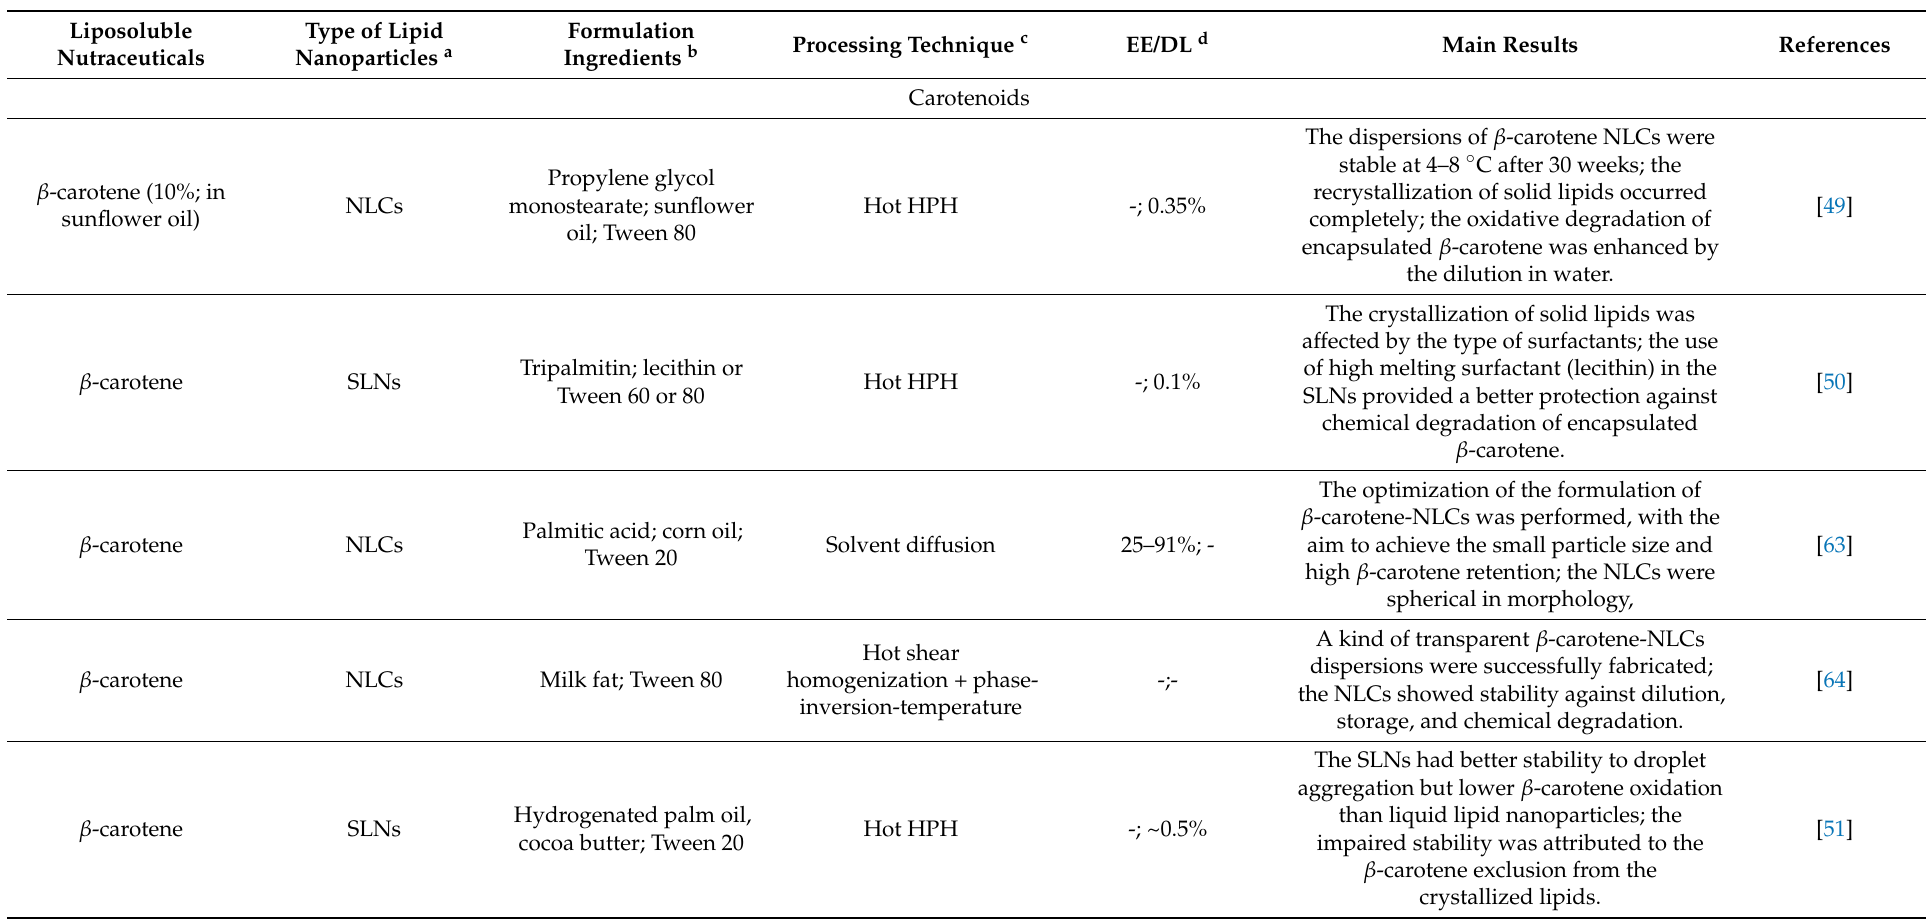
Table 1. A summary of some representative works addressing the development and/or utilization of SLNs and NLCs as nanovehicles for liposoluble nutraceuticals or